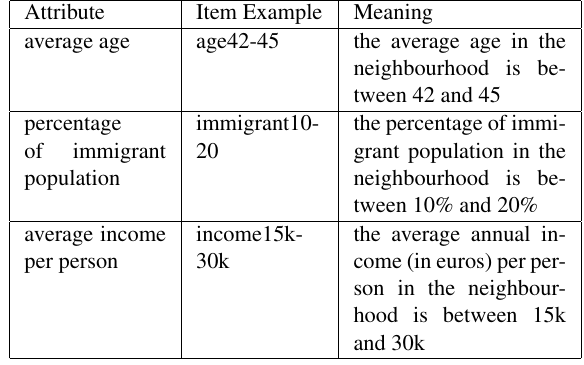
Table 1. Examples of items generated from the demographic data.